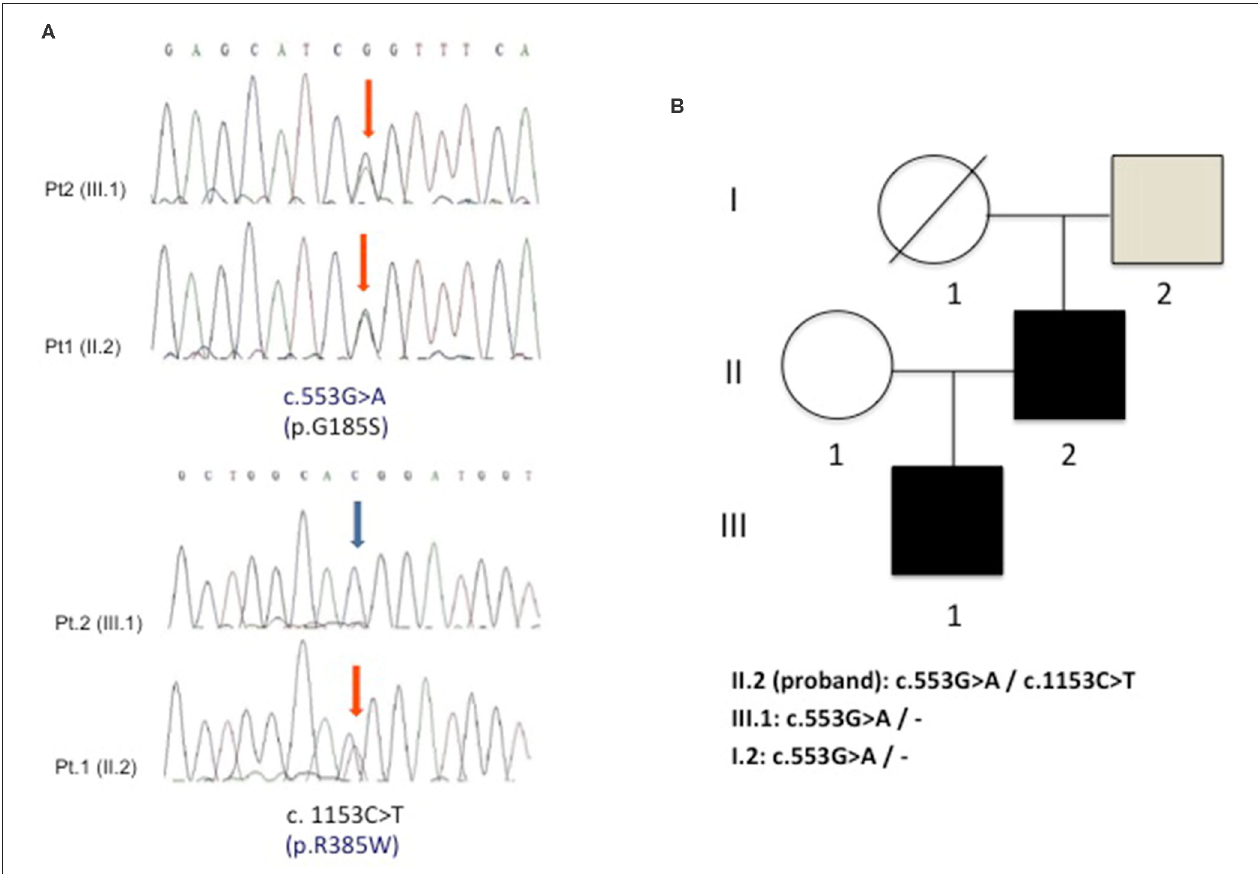
FIGURE 2 | (A) Electropherogram of ACADVL showing the two heterozygous substitutions c.553G > A (p.G185S) and c.1153C > T (p.R385W) in the proband (pt. 1) and the presence of only c.553G > A (p.G185S) in the son (pt. 2). (B) Family tree shows the segregation of the two G185S and R385W mutations in the analyzed family